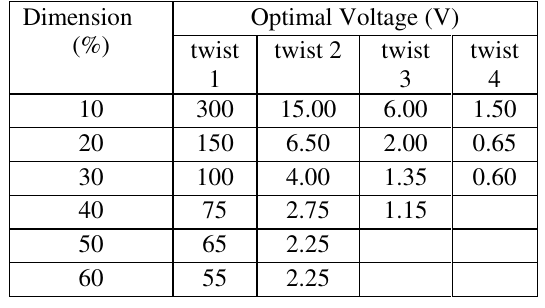
Table 6. Reduction